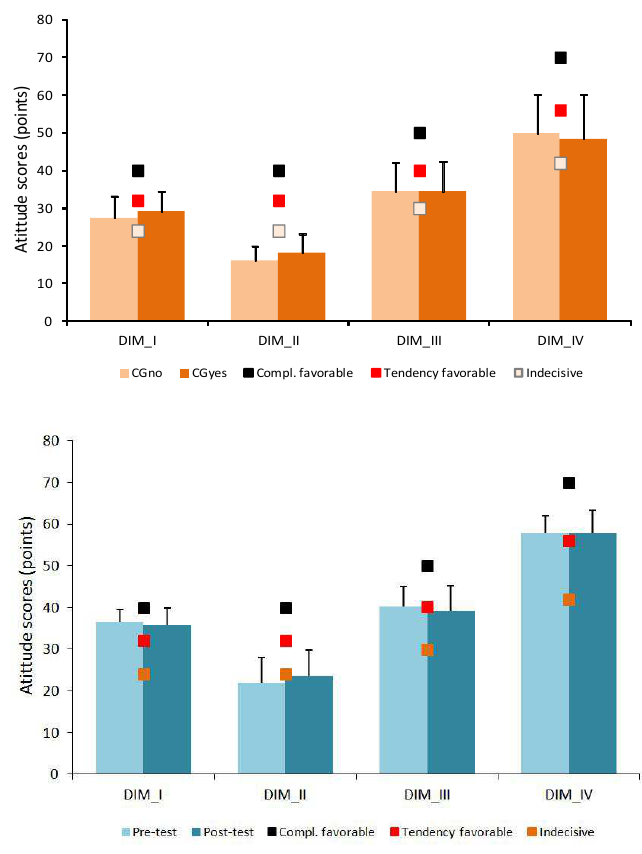
Figure 4. Attitude scores in each of the four attitude dimensions for the IG pre- and post-test (left side), CGno and CGyes groups (top), and respective comparisons with the upper scores predicted in each dimension for “completely favorable toward inclusion,” “tendency favorable toward inclusion,” and “indecisive toward